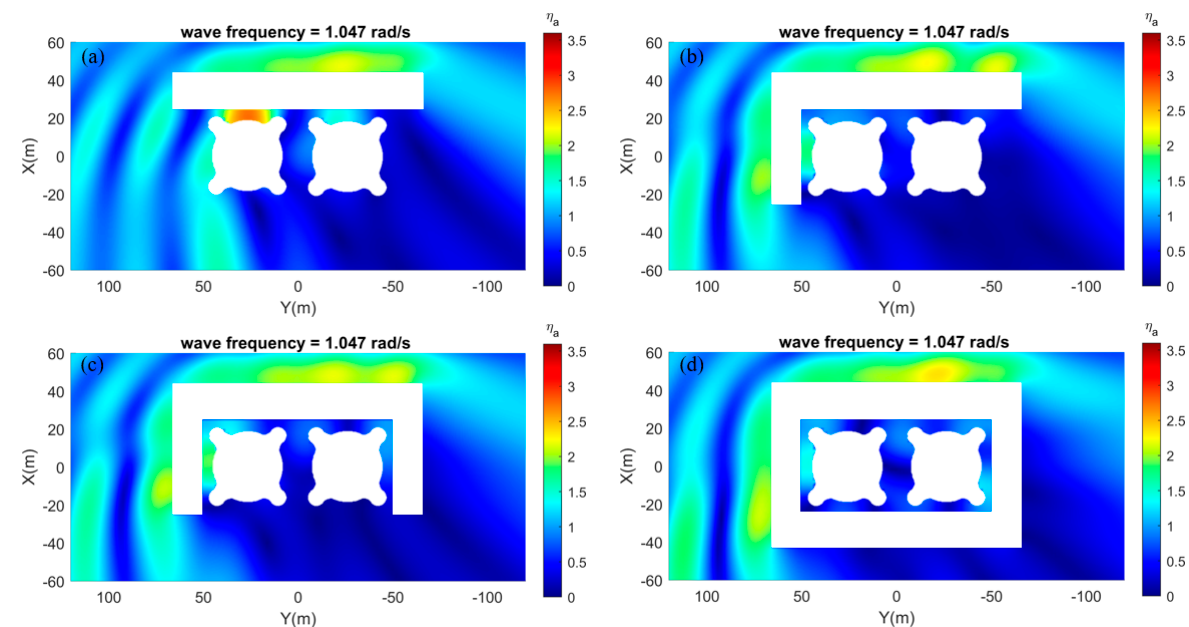
Figure 18. Amplitude of free surface elevations around the floating tanks and the breakwaters in 0 deg wave direction, with wave frequency of 1.047 rad/s for ( a ) conventional single floating breakwater, ( b ) L-shape, ( c ) U shape, and ( d ) barge frame